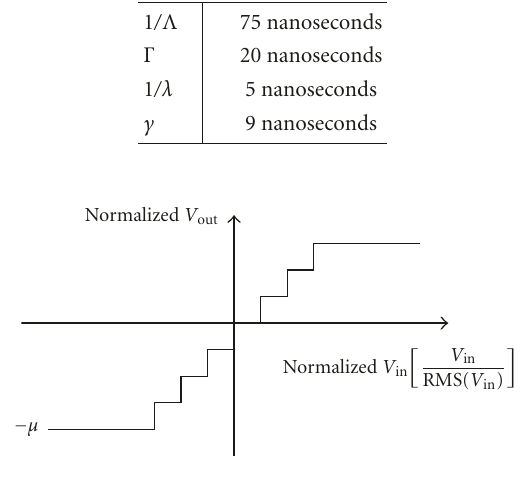
Figure 1: ADC input-output